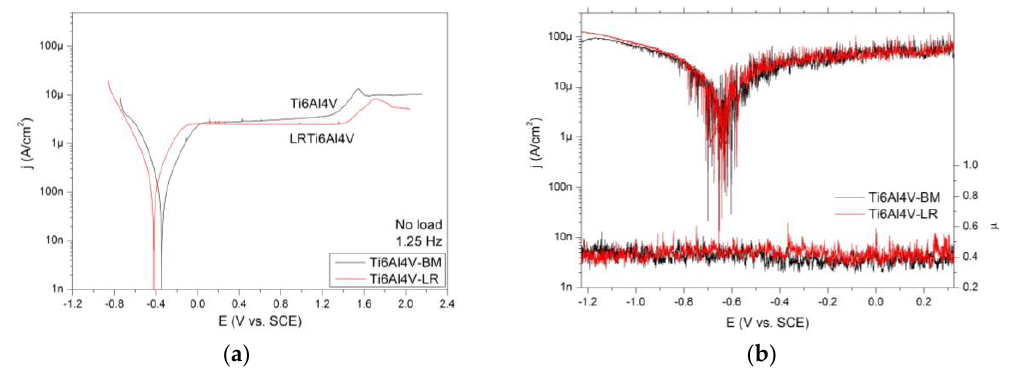
Figure 10. ( a ) Polarization curve without load; ( b ) with 2.0 N load: potential versus coefficient of friction, and polarization curve. (Black, Ti 6 Al 4 V-BM; red, Ti 6 Al 4 V-LR).